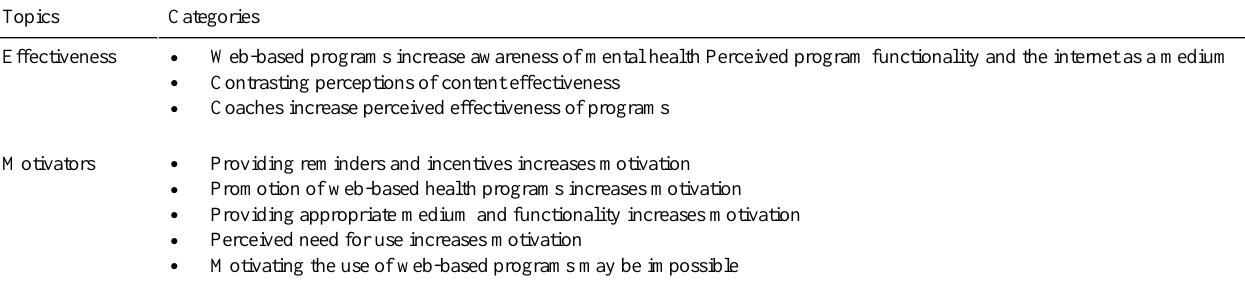
Table 2. Summary of the categories that were found through content analysis divided into their respective